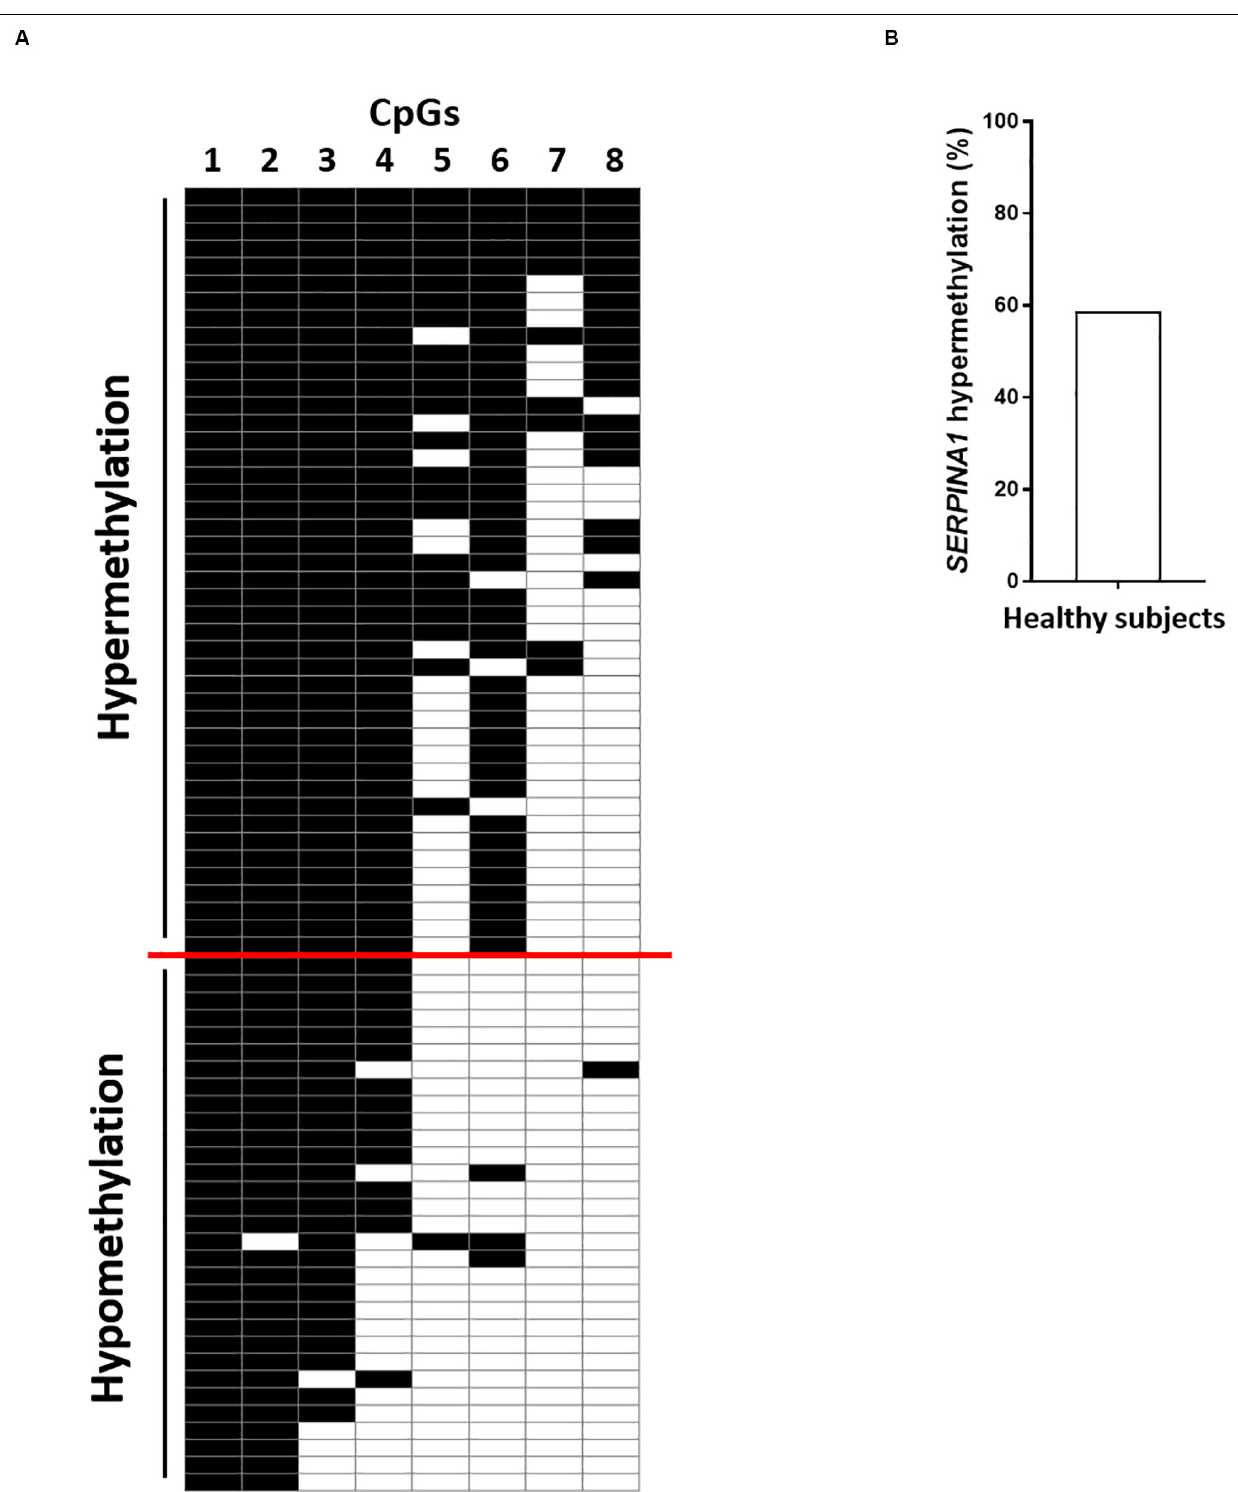
Frontiers in Cell and Developmental Biology | www.frontiersin.org